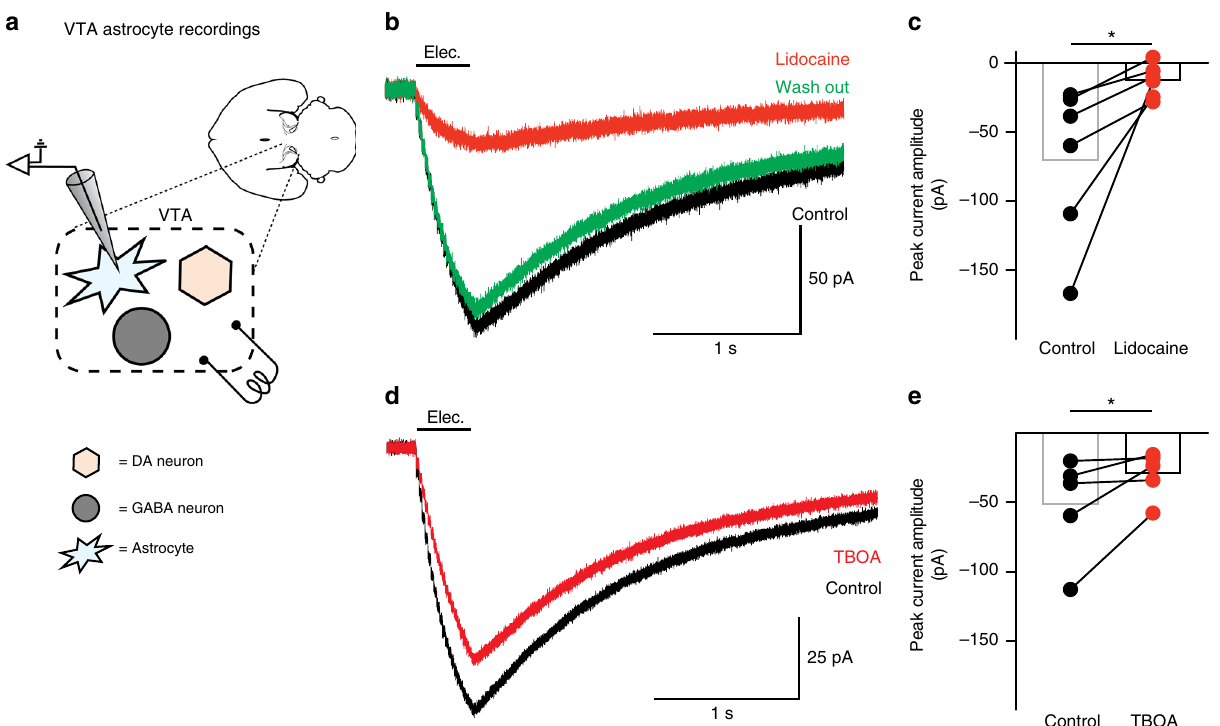
Fig. 1 Neuronal afferent activity changes glutamate transport in VTA astrocytes. a Schematic showing the microcircuitry of the VTA and recordings performed. b Recording from a VTA astrocyte showing the current generated by electrical stimulation (black; 50 Hz, 20 pulses), the current remaining after blocking action potentials with 250 µ M lidocaine (red), and after washing out lidocaine (green). c Summary of the currents before (black) and after lidocaine application (red; paired t -test t (5) = 2.679, P = 0.04, n = 6 cells, 4 mice). d Current generated in a VTA astrocyte by electrical stimulation of afferents before (black) and after adding 15 µ m TFB-TBOA (red). e Summary of the currents generated by electrical stimulation in VTA astrocytes before (black) and after (red) addition of TFB-TBOA (paired t-test t (4) = 2.159, P = 0.04, n = 5 cells, 5 mice). *: P <